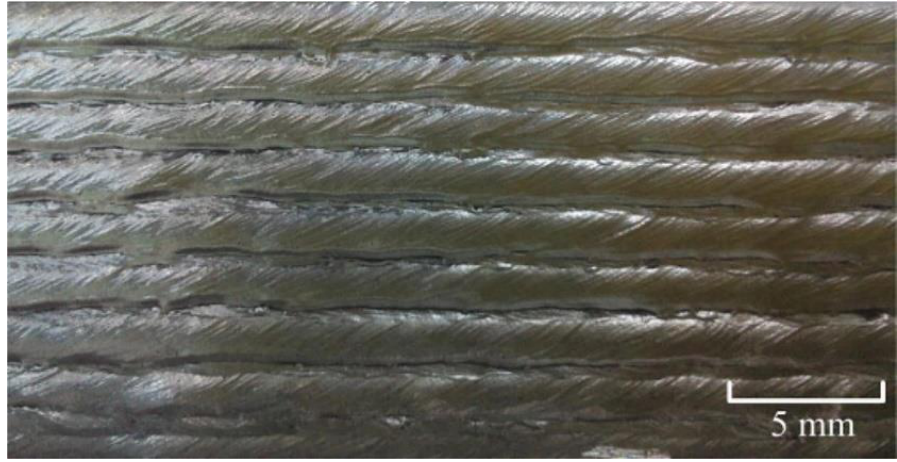
Figure 12. Surface topography of a specimen manufactured by wire arc additive manufacturing (WAAM). Reproduced from [141] (Open access, no copyright).